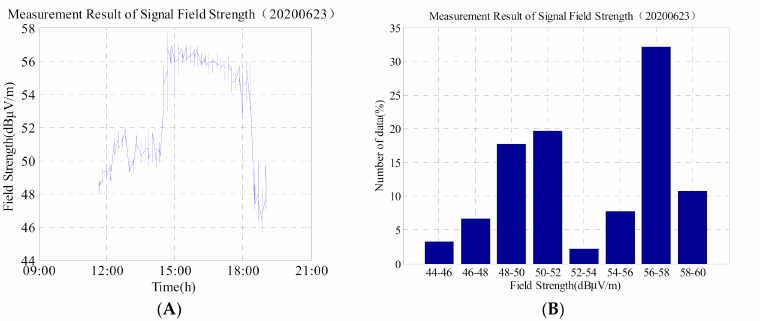
Figure 9. ( A ) Field strength change of the low-frequency time-code signal on 23 June 2020; and ( B ) corresponding histogram. Total number of data is 780.